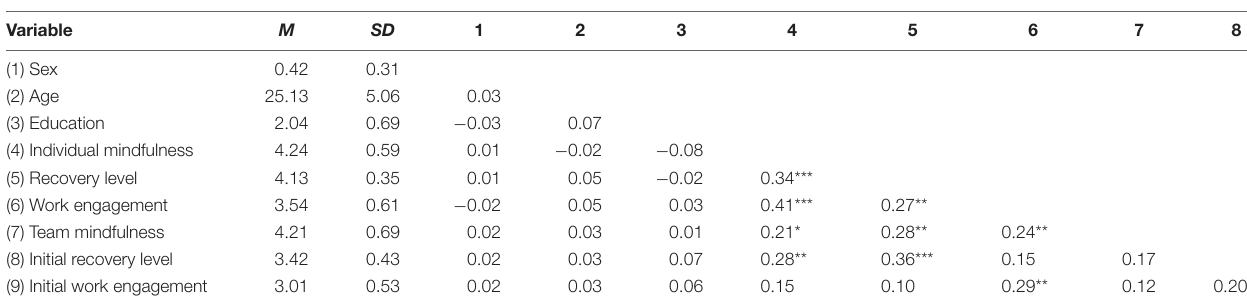
TABLE 1 | Descriptive statistics and